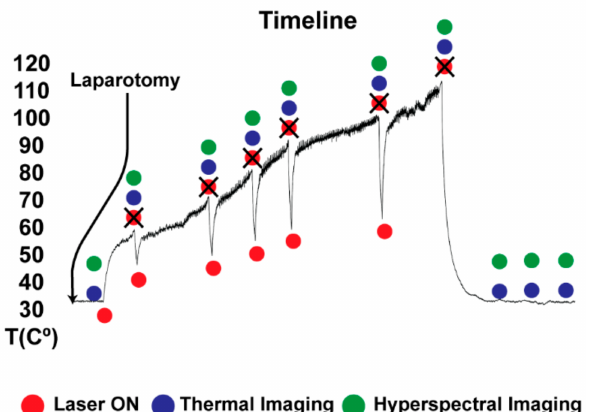
Figure 2. After laparotomy, liver tissue was irradiated until specific temperature thresholds occurred. The temperature was monitored continuously using the IR video. Once the set temperature threshold was reached, the laser system was switched off and the HS data (hypercube and RGB image) were